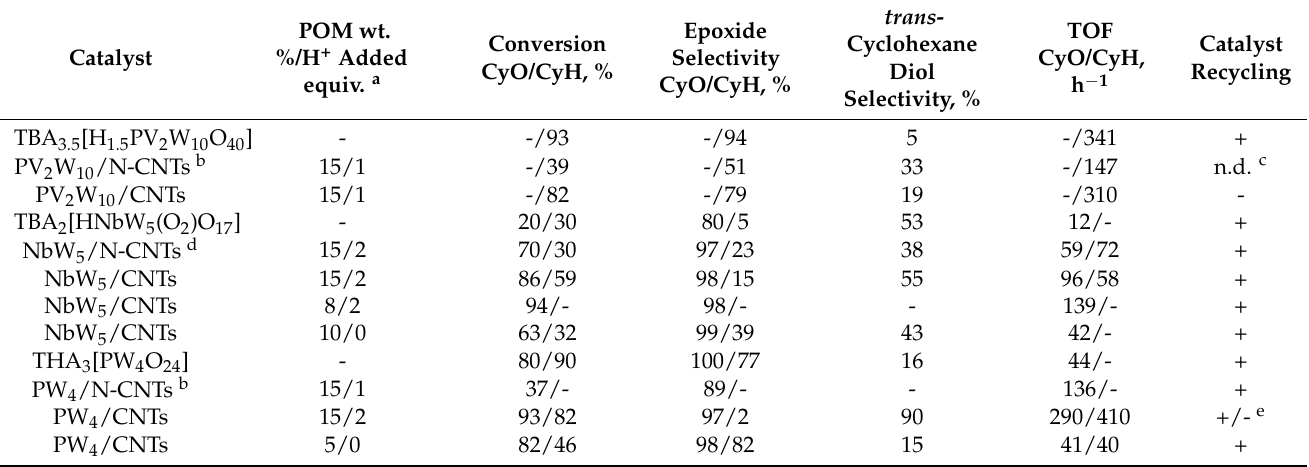
Table 3. Catalytic performance of POM/(N)-CNTs in H 2 O 2 -based oxidation of CyO and CyH in comparison with homogeneous POM (the data taken from refs. [101–103]).